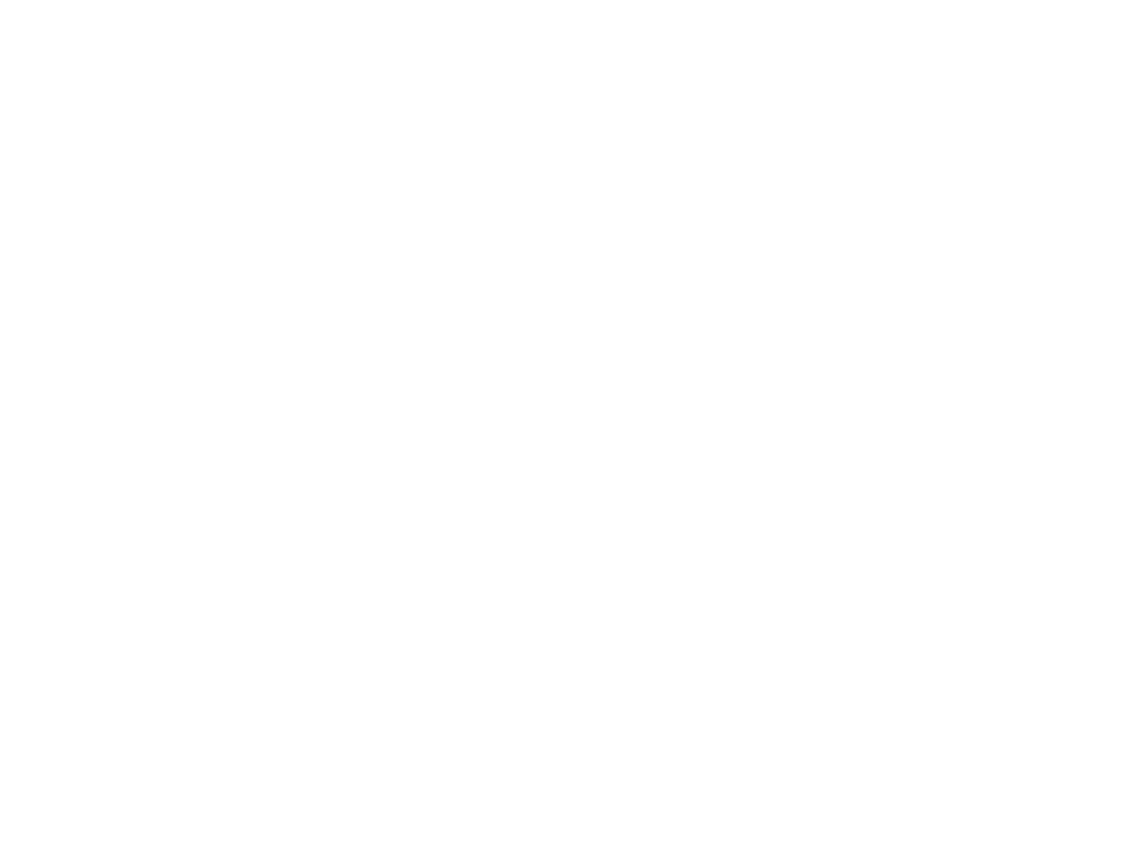
significant BOLD signal increase across all subjects. For a full list of activated regions ( z > 2.3, whole-brain cluster-corrected, p < 0.05), see TableA1